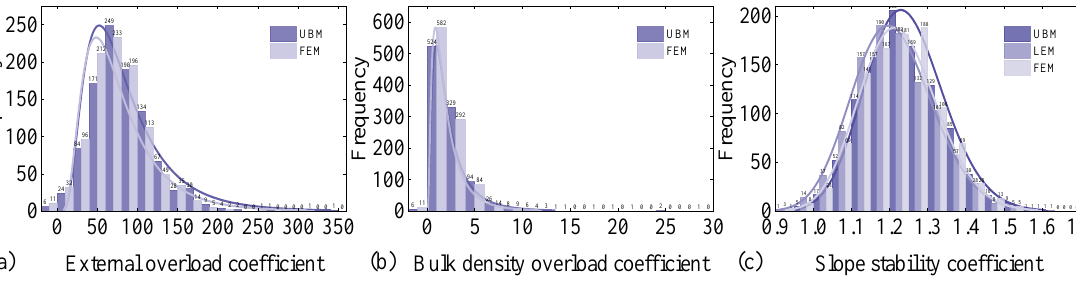
(c)(b)(a) k t , ( ) k t of homogeneous k t Figure 5. Histogram of ( ) and ( ) F m m m m  Figure 5. Histogram of of homogeneous slope. Figure 5. Histogram of and of homogeneous slope.